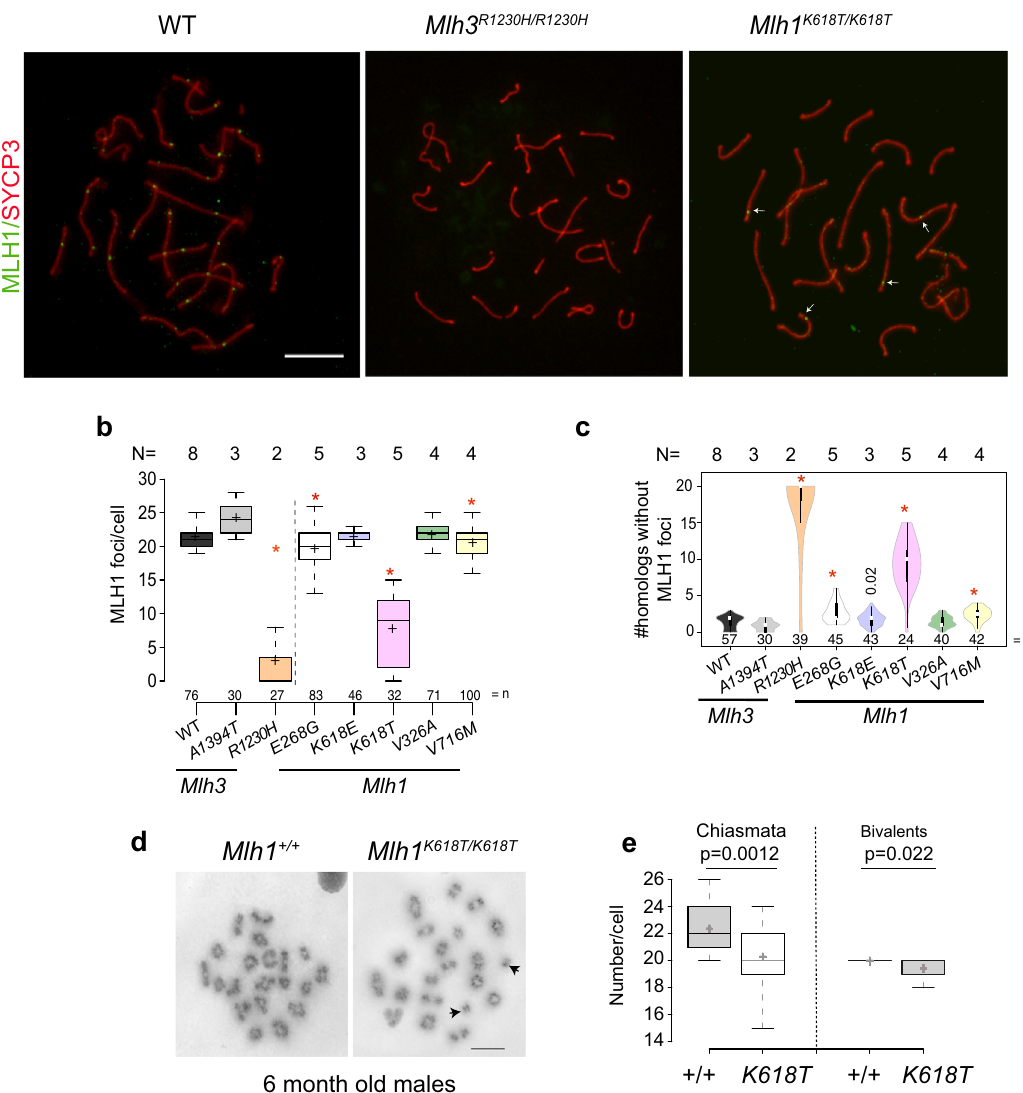
Fig. 2 Recombination in mutant spermatocytes. a MLH1 immunolocalization in spermatocyte nuclei. Shown are pachytene spermatocyte chromosome surface spreads from 6 month old males, immunolabeled with SYCP3 (red) and MLH1 (green). White arrows indicate MLH1. Note weak and nearly absent staining in the mutants. b MLH1 focus quanti fi cation in spermatocytes. * p -value <0.0001. Others do not have p -values < 0.05 for decreased foci. Over 30 cells from at least 3 animals were quanti fi ed, except for Mlh3 R1230H , where 27 cells from two animals were scored. c Violin plots illustrating the chromosome pairs in a spermatocyte nucleus lacking an MLH1 focus. White circles show the medians; box limits indicate the 25th and 75th percentiles; whiskers extend 1.5 times the interquartile range from the 25th and 75th percentiles; polygons represent density estimates of data and extend to extreme values. For mutants with more MLH-de fi cient pairs, * p -value <0.0001 unless otherwise indicated; comparisons to WT with p -values >0.05 are not shown. d Example of spermatocyte metaphase spread from the Mlh1 K618T mutant and control. e Quanti fi cation of chiasmata and bivalents in Mlh1 K618T and WT. Twenty or more cells from three animals were analyzed. Scale Bar = 5 μ m. Data in b and e are plotted as follows: Boxes indicate data points between the fi rst and third quartiles of the distribution, whiskers show minimum and maximum values, black horizontal lines and ‘ + ’ sign indicate the median and mean values respectively. Data in b , c and e were analyzed using Unpaired Student ’ s t -test from the total number of spermatocytes (shown as ‘ n ’ ) from multiple animals indicated as ‘ N ’